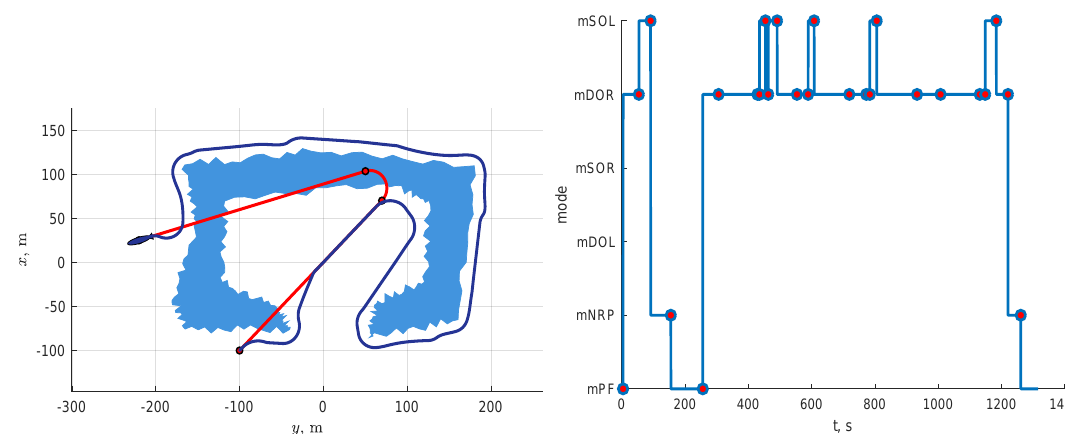
Figure 14. Simulation results for Scenario 2: U-shaped obstacle environment. The explanation of the figure is the same as that of Figure 9.